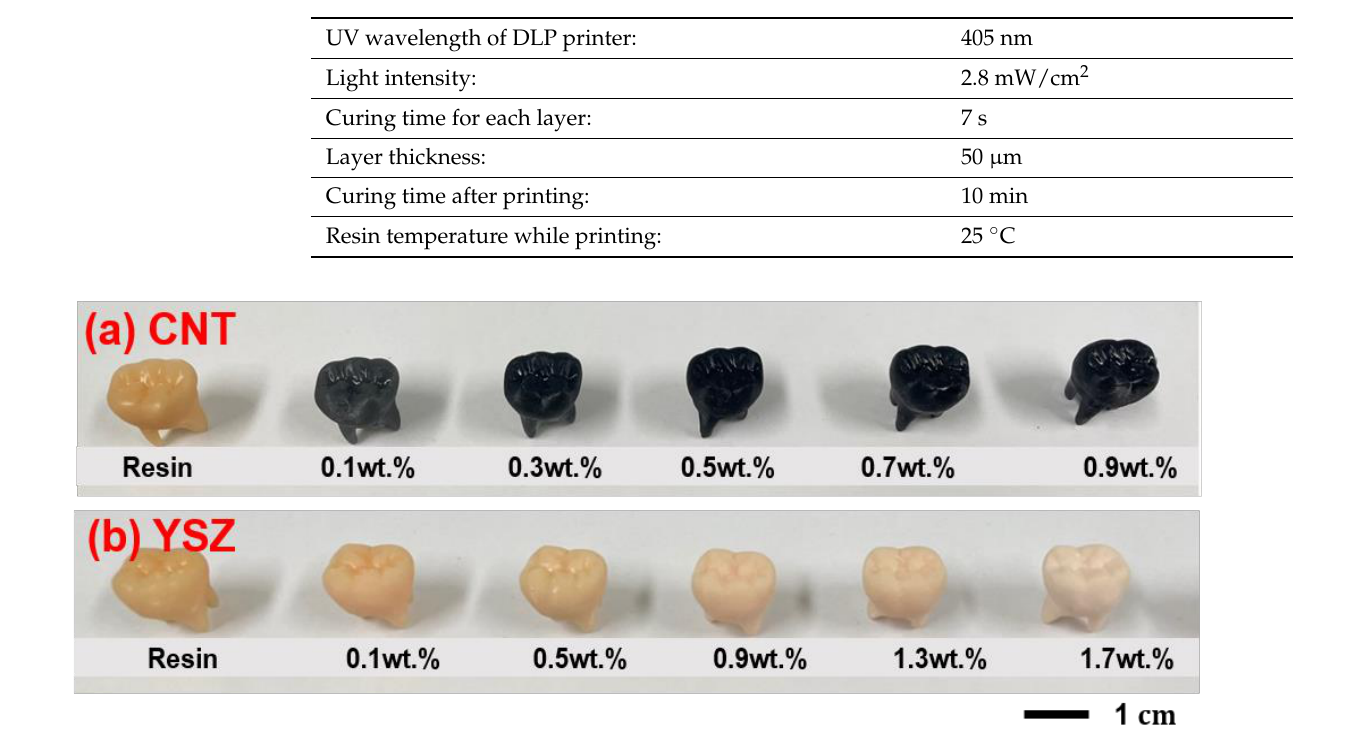
Table 1. All the DLP printing parameters used in the present work.